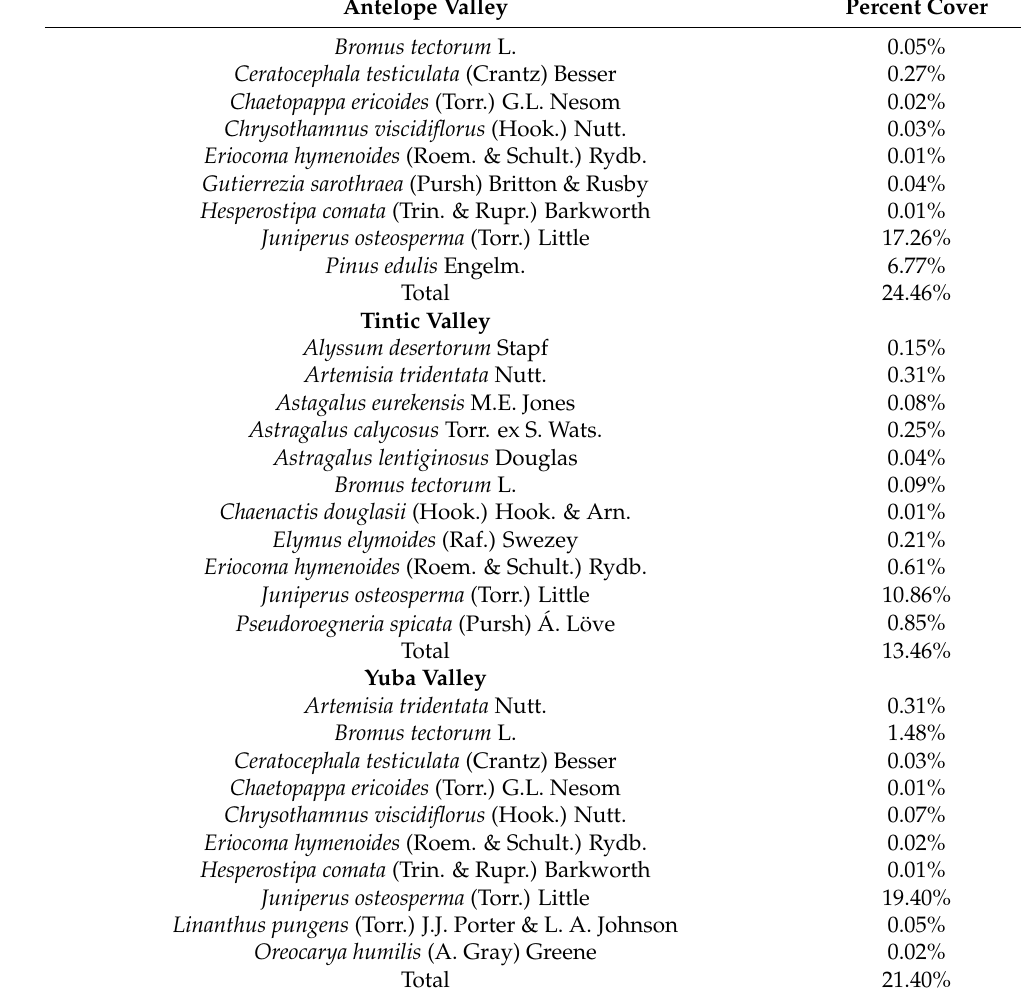
Table 1. Species Composition in Pinyon/Juniper Habitat Type. Antelope Valley Percent Cover Bromus tectorum L.